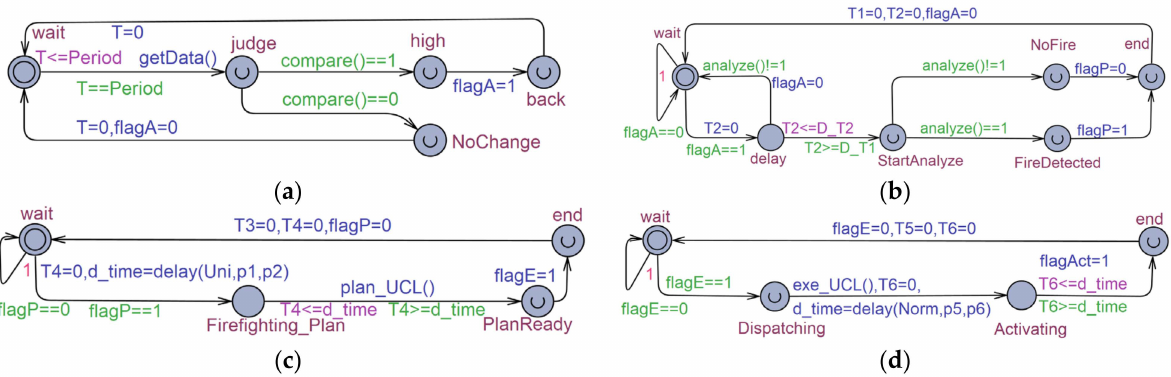
Figure 14. Modeling the Fire Detection System by reusing and simplifying the templates of Timed- SAS: ( a ) reusing the templates of Monitor and M Period ; ( b ) reusing and simplifying the templates of Analyze and A Delay ; ( c ) reusing and simplifying the templates of Plan and Delay Plan ; and ( d ) reusing and simplifying the templates of Execute and Delay Execute